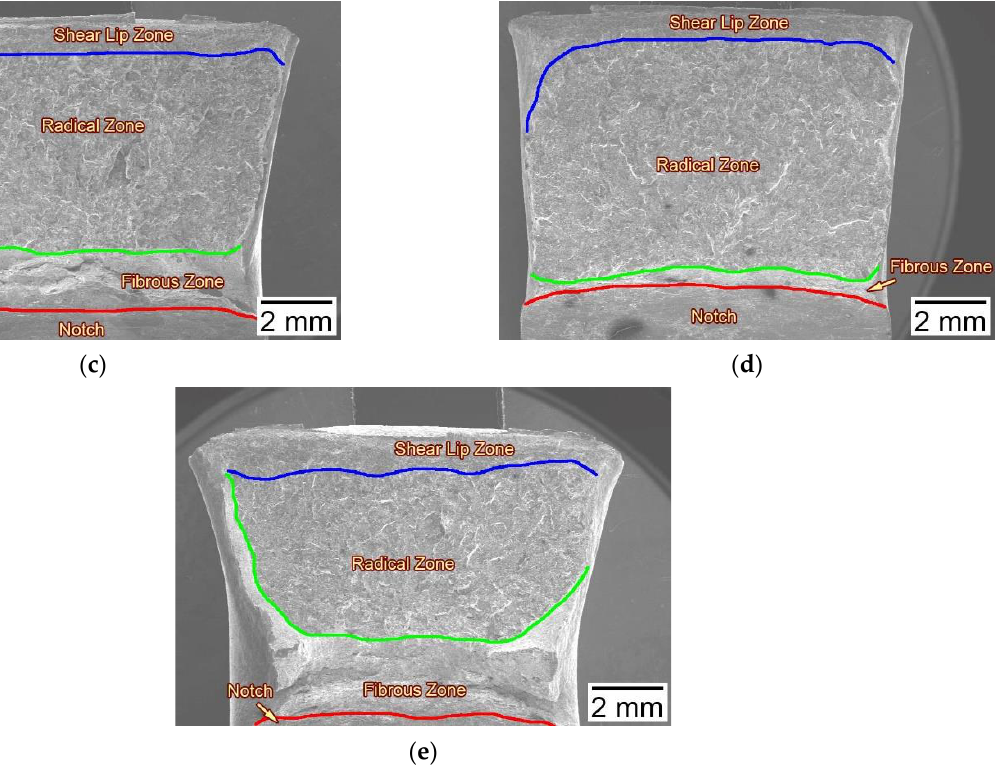
Figure 6. SEM-SE images showing the complete fracture surface of the CGHAZs of ( a ) 2Ca, ( b ) 11Ca-1, ( c ) 11Ca-2, ( d ) 18Ca-1 and ( e ) 18Ca-2 steels after large-heat-input welding at 400 kJ cm −1 .